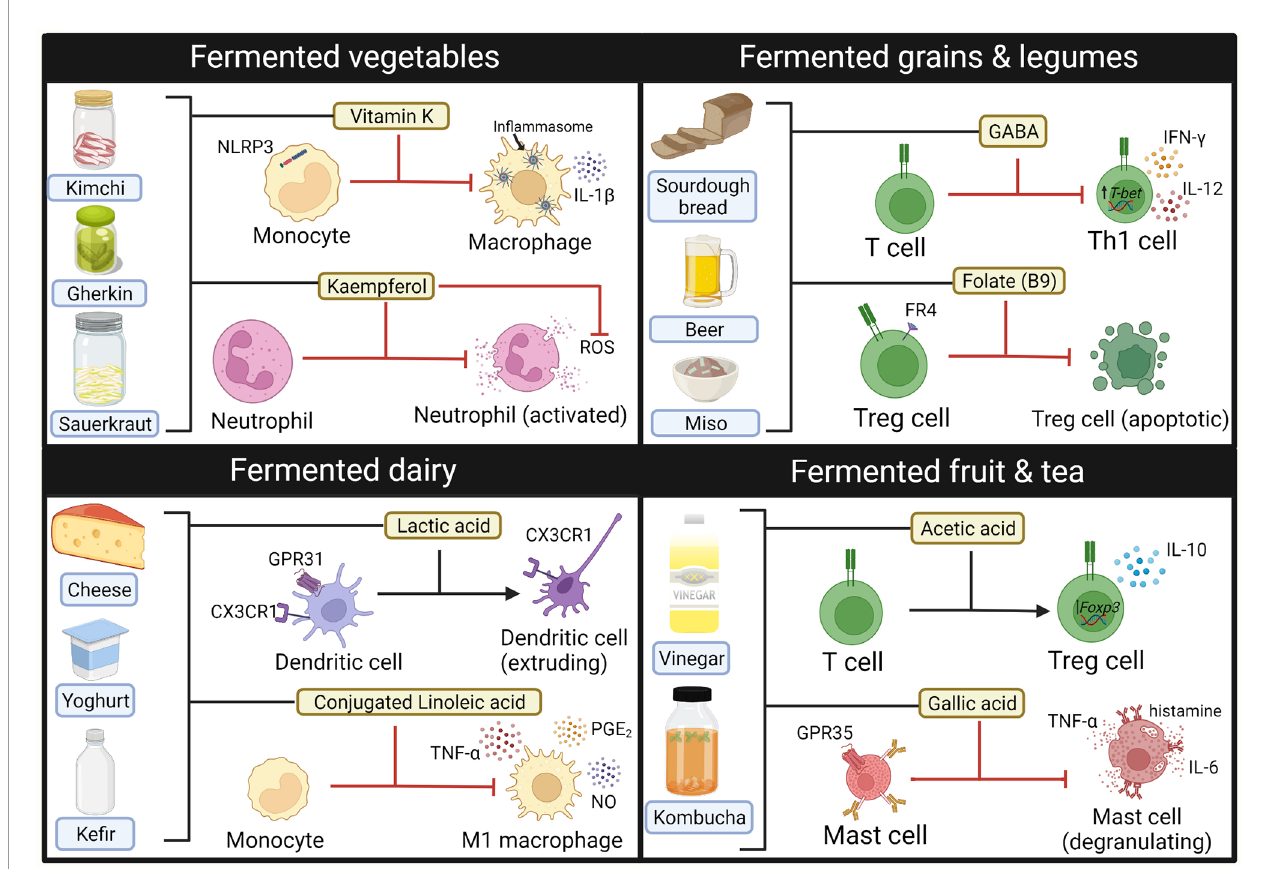
FIGURE 3 | Immune modulating compounds contained within Fermented foods. Bioactive compounds from fermented foods that have anti-in fl ammatory effects on the activity and phenotype of innate (macrophages, neutrophils, mast cells) and adaptive (T-cells) immune cells. GABA, gamma-aminobutyric acid. Created with